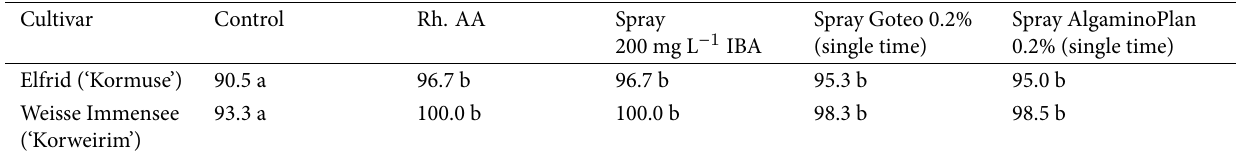
Table 4 The effect of IB, Goteo, and AlgaminoPlant on the percentage of rooting in cuttings of Rosa Elfrid (‘Kormuse’) and Weisse Immensee